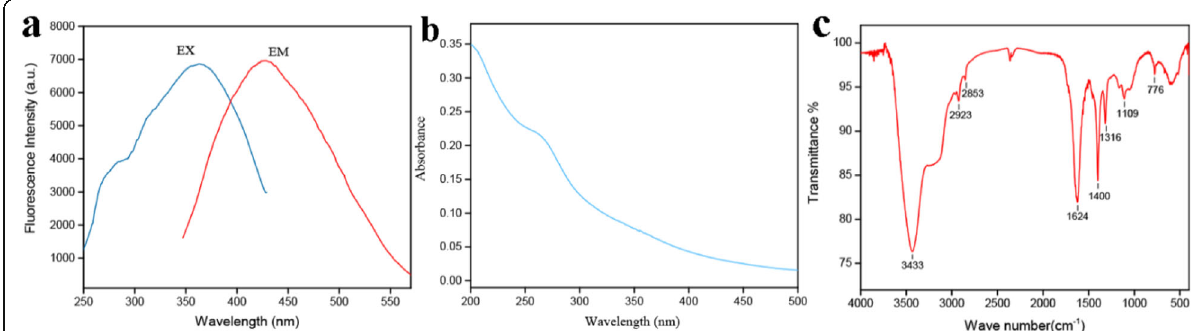
Fig. 3 Optical properties of Phellodendri Cortex Carbonisatus carbon dots (PCCC-CDs). a Fluorescence spectra, b ultraviolet-visible spectra (UV-Vis) and c Fourier transform infrared spectrum (FTIR)